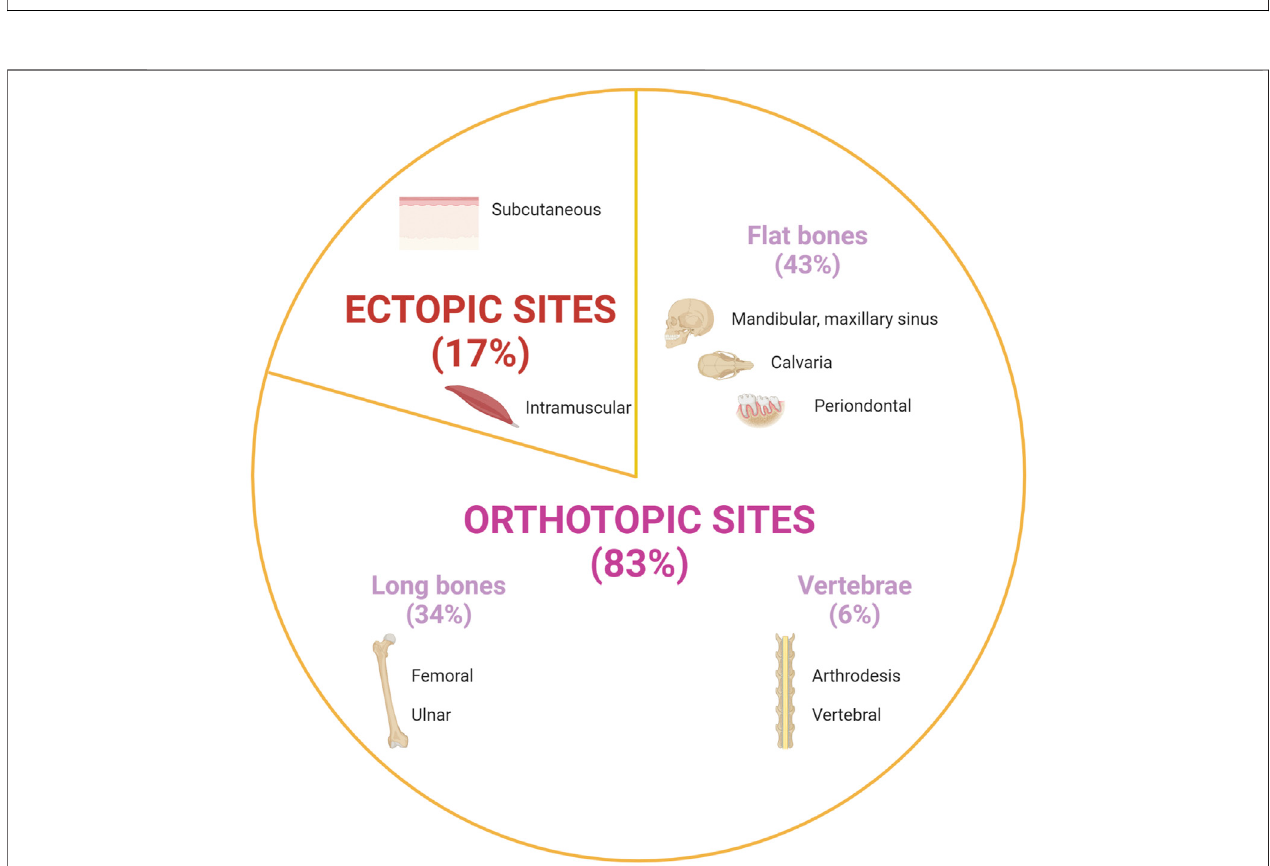
Frontiers in Bioengineering and Biotechnology |